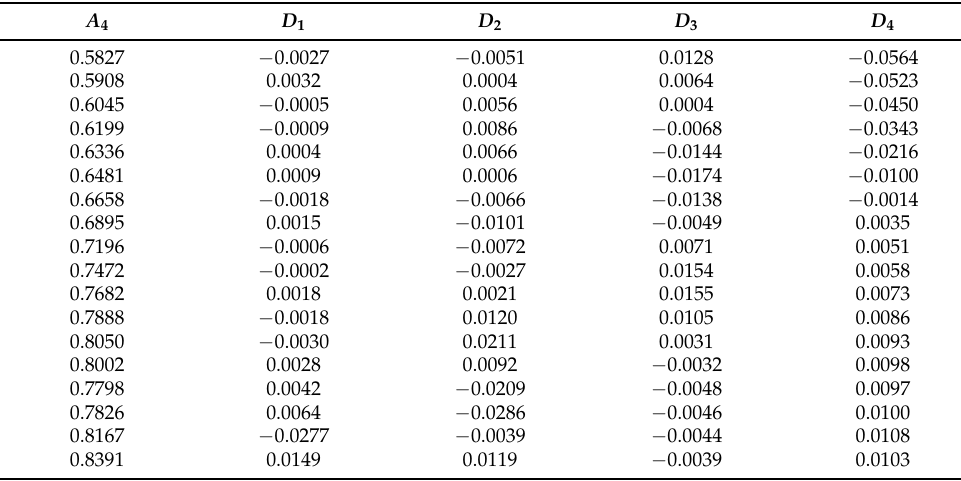
Table 8. Four-level wavelet decomposition of V 7